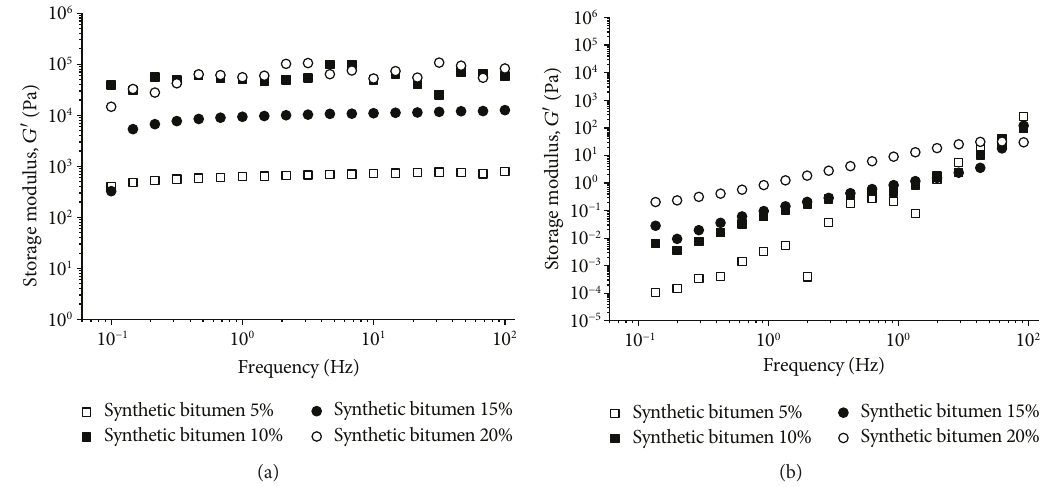
Figure 1: Storage modulus, G ′ ω , (a) for synthetic bitumen compositions at 25 ° C and (b) for synthetic bitumen compositions at 150 ° C.